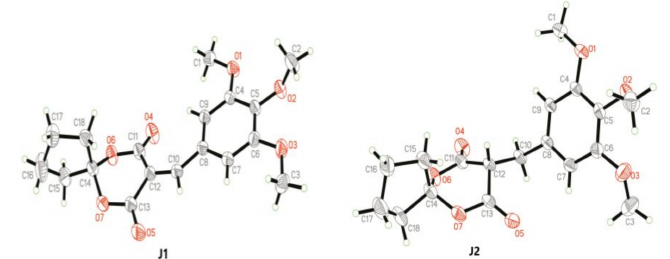
Figure 1. The molecular structures of J1 and J2 with an atomic numbering